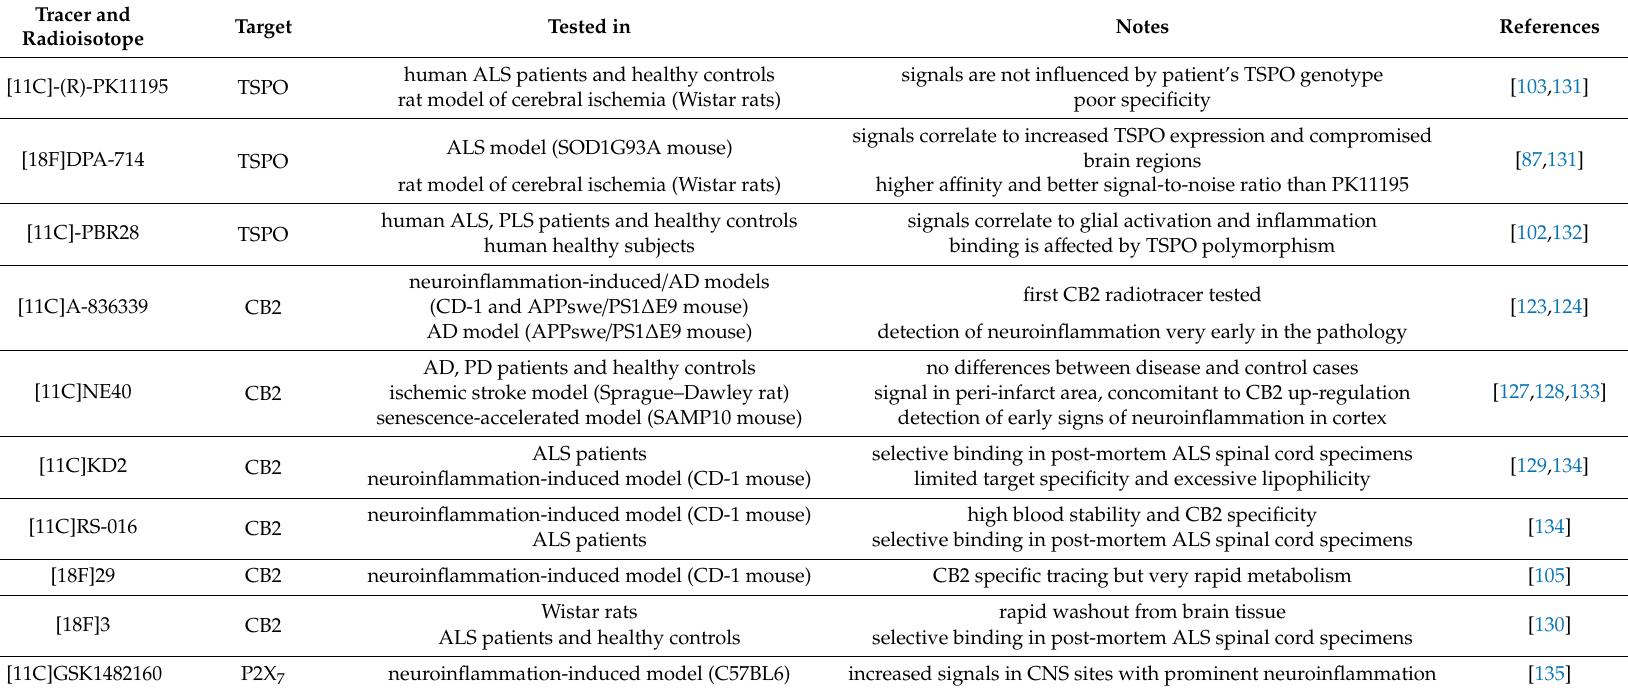
Table 2. Pet tracers of